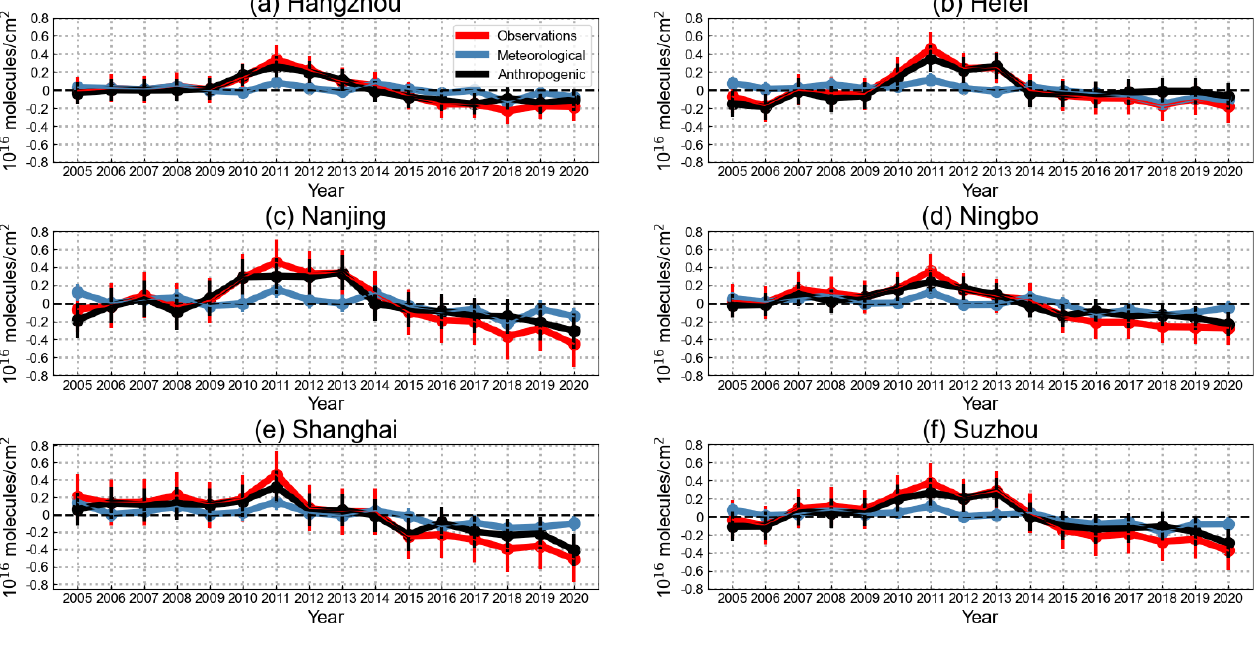
Figure 7. The same as Fig. 6 but for annual